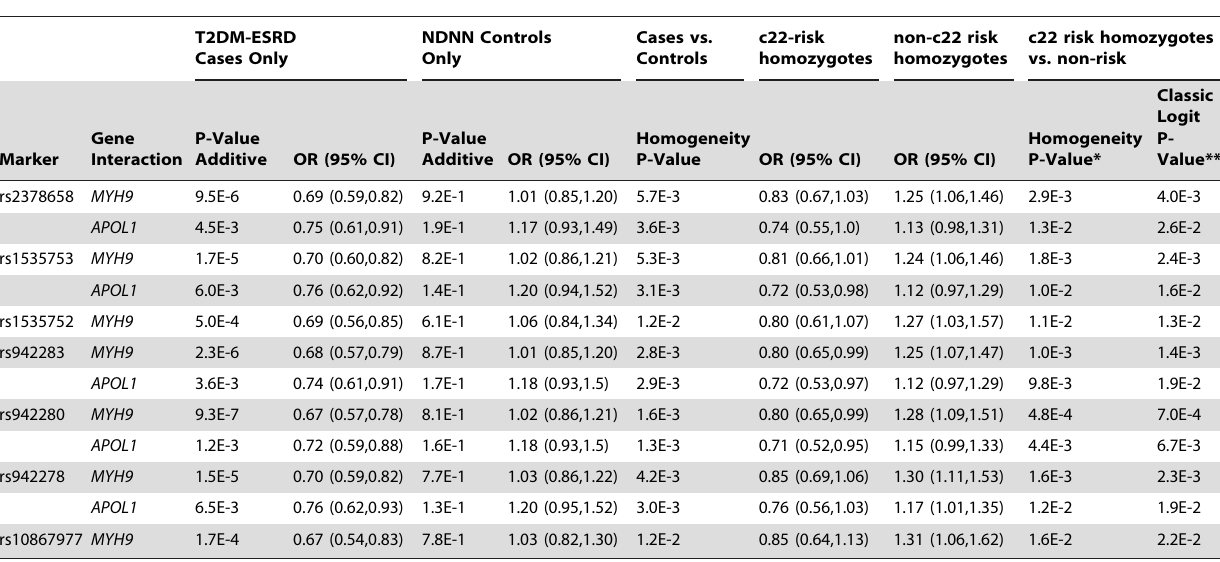
Table 4. Combined chromosome 22- FRMD3 interaction analysis.